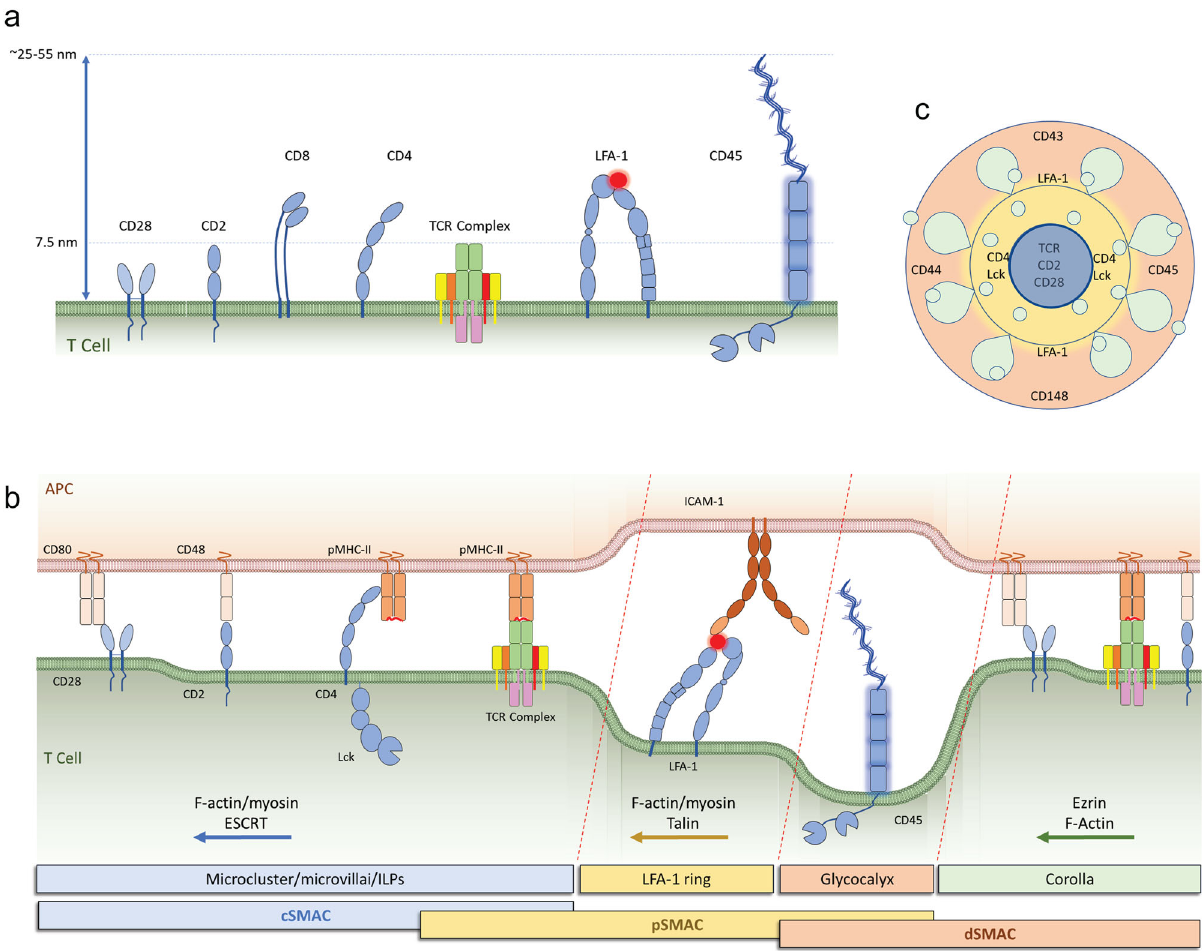
Fig. 1 T cell surface and the immune synapse. a The T cell surface is populated with receptors displaying different dimensions ranging from one Ig-like domain (3.5 nm) to those with long and bulky extracellular domains such as CD45 with a rigid core of 15.2 nm and variable mucin-line domain that extends the height to 10 (CD45R0), 20 (CD45RA), or 40 (CD45RABC) nm. The repetition of the mucin-like domain may increase the space it occupies in cell interfaces. b Upon APC/T cell engagement, and following TCR triggering, T cell surface proteins sort based on size and F-actin based transport to distinct zones. The mature immune synapse takes 10 – 30 min to develop, and three zones are arranged in circles, with proteins subjected to strong F-actin and ESCRT based transport in the cSMAC, proteins linked to F-actin/myosin, such as LFA-1 ligated to ICAM-1, in the pSMAC, and proteins with the weakest F-actin coupling in the dSMAC. c In addition, some proteins linked directly to TCR triggering such as Lck kinase accumulate in the pSMAC where